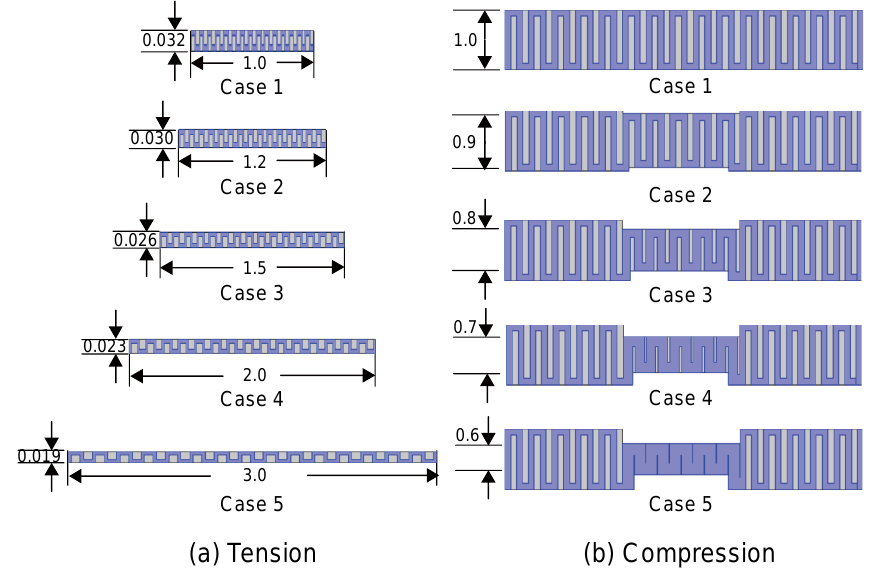
Figure 2. Numerical models of a conductive fabric under tension and compression. The blue and grey regions denote the conductive yarns and air gaps, respectively. ( a ) Models of the conductive fabric subject to different amounts of tension at the edges. ( b ) Models of the conductive fabric subject to compressive forces at the